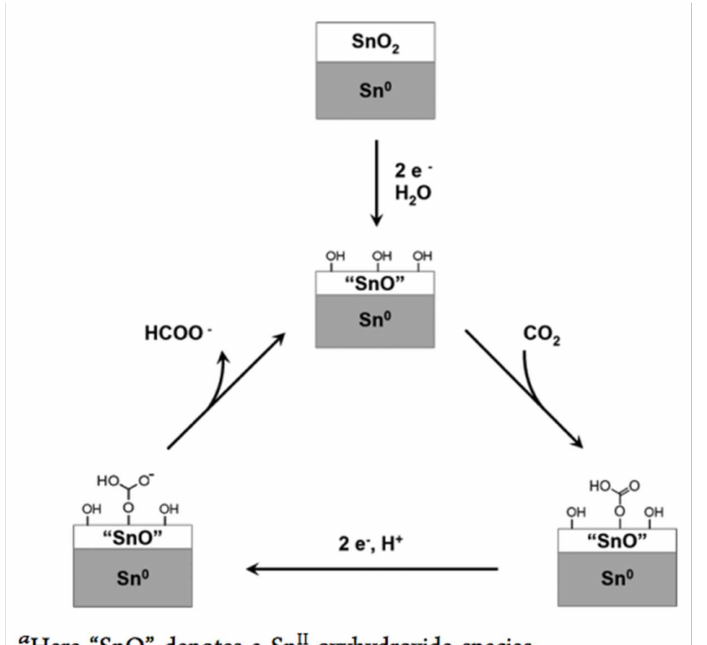
Figure 10. Proposed mechanism for the reduction of CO 2 to formate on Sn/SnOx cathodes. Repro- duced with permission from Ref. [129]. Copyright 2015 American Chemical